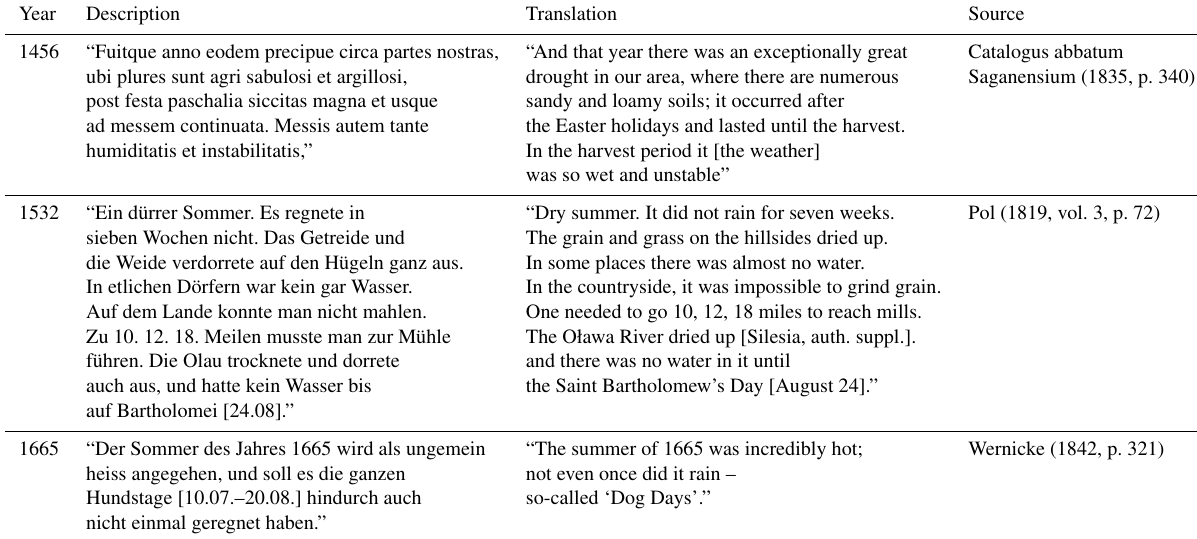
Table 4. Examples of descriptions of severe droughts in 15th–17th-century sources.